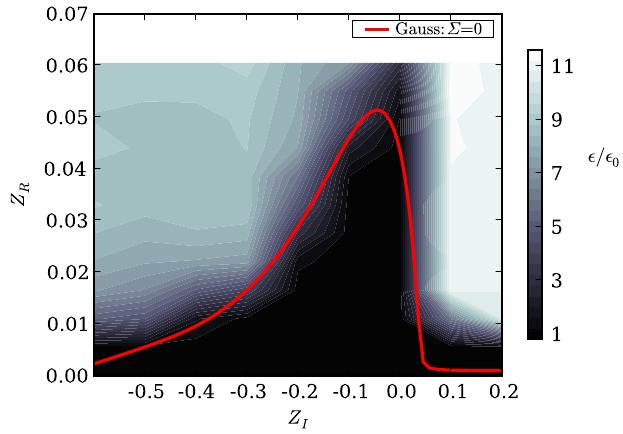
FIG. 6. (Color) Simulation scan of the stability boundary in the normalized impedance plane for a single rf wave and no space charge ( (cid:1) (cid:7) 0 ). The bunch length of the initially matched (cid:7) 60 (cid:12) . The red curve represents Gaussian distribution is (cid:1) m the stability boundary obtained from the dispersion relation equation (28) for (cid:1) (cid:7) 0 .